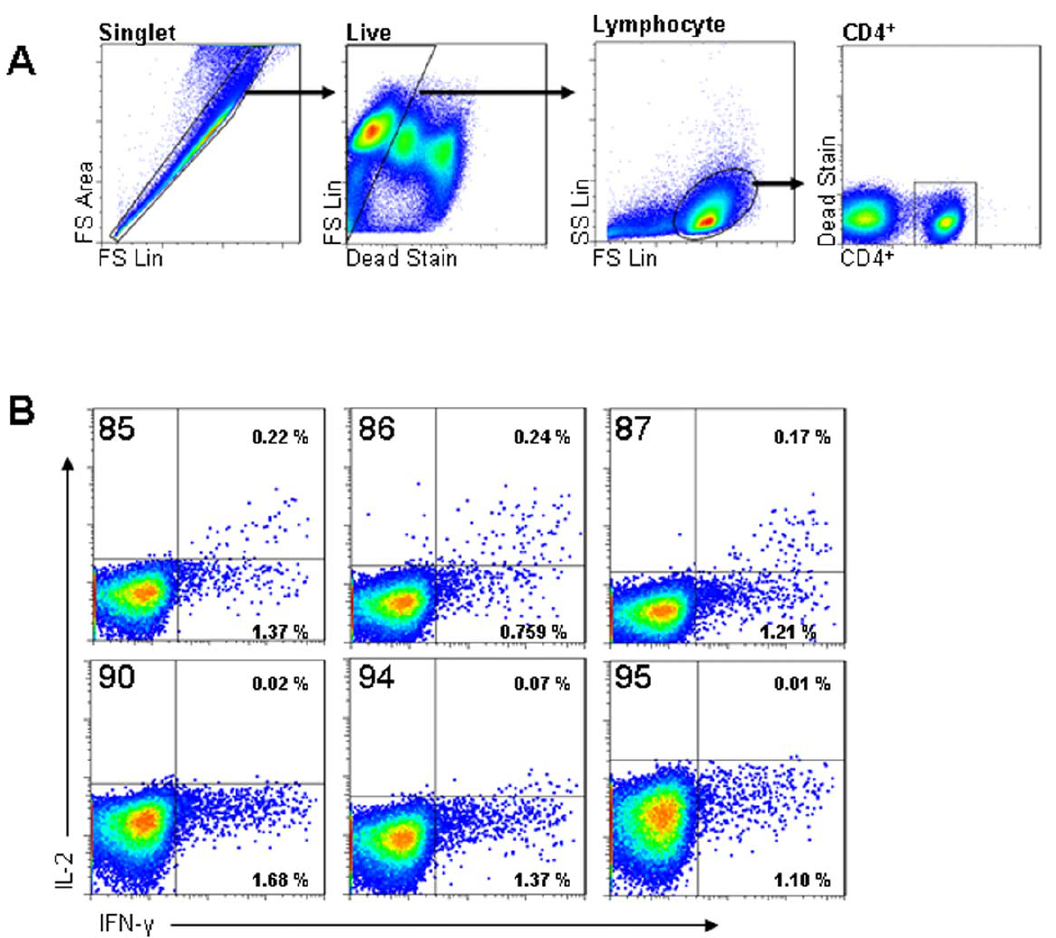
Figure 1. Identification of recombinant antibodies with specificity for bIL-2. PBMC from a cow naturally infected with M. bovis were cultured in the presence of PPD-B to allow screening of candidate bIL-2 by ICS flow cytometry. Panel A shows the histogram gating strategy used to interrogate responses in singlet, live CD4 + lymphocytes. Panel B shows the measurement of detectable IL-2 and/or IFN- c within the CD4 + population for each of 6 candidate IL-2 antibody clones. The clone number is shown in the top left corner of each histogram and the percentage of CD4 + cell in which co- expression of IFN- c and IL-2 could be detected is shown in the top right of each histogram. Data are representative of 1 of 2 independent experiments.